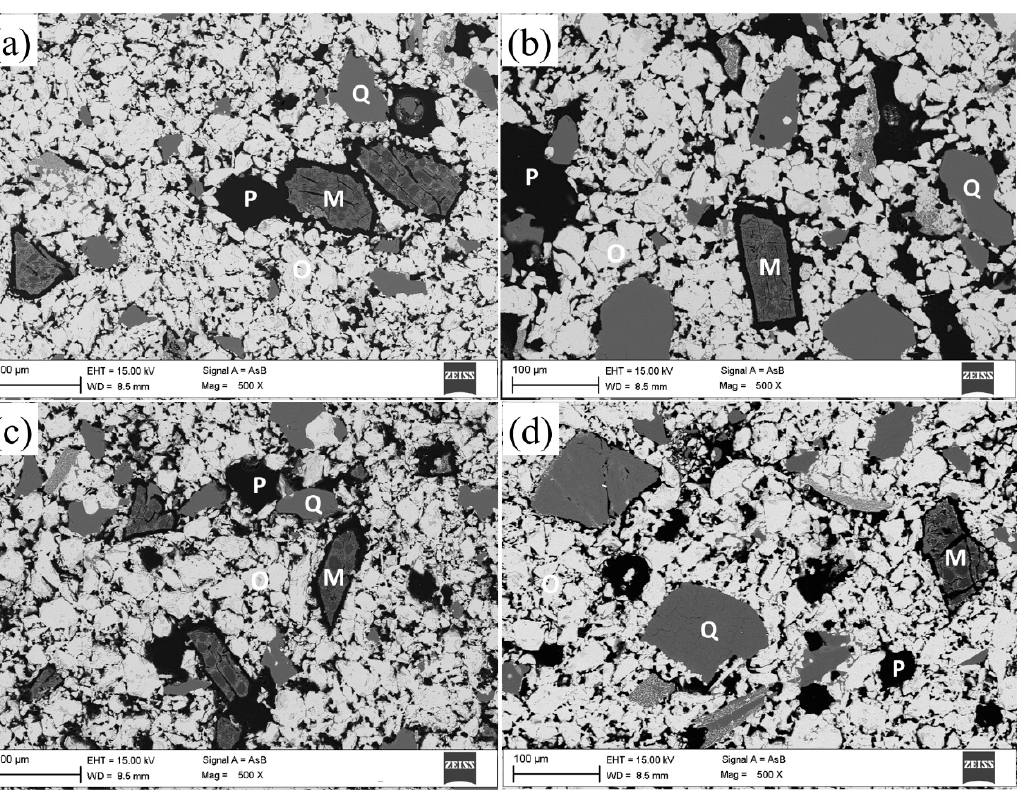
Figure 2. Backscattered electron images by FESEM from the core of pellets sized ( a ) 8–10 mm, ( b ) 10–12.7 mm, ( c ) 12.7–16 mm and ( d ) 16–20 mm. “O” stands for iron oxides (hematite and/or magnetite), “M” for magnesite, “Q” for quartz and “P” for pore.